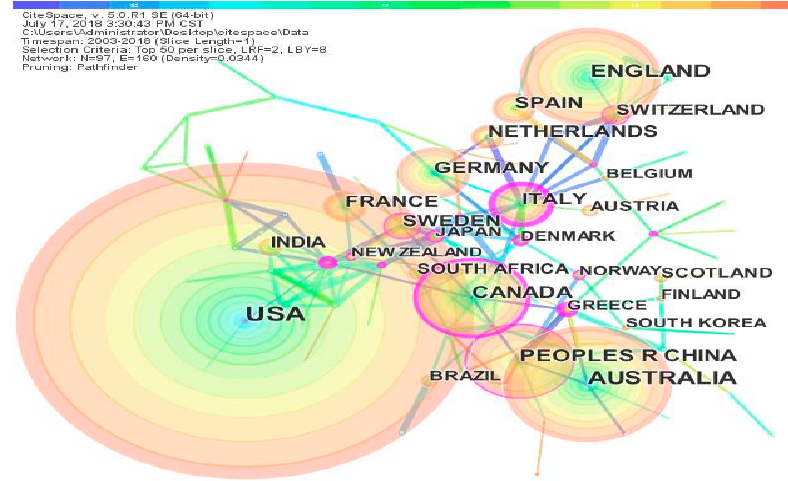
Figure 5. National collaboration network.